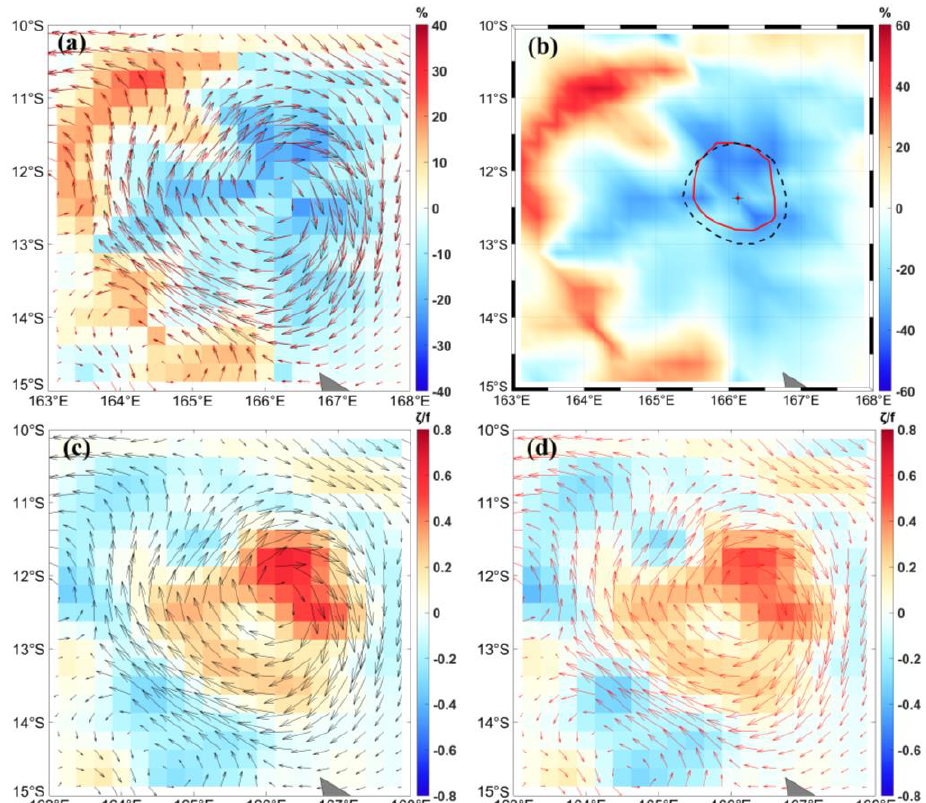
Figure 4. Cyclogeostrophic correction of an isolated cyclonic eddy in the southern hemisphere on 1 February 2003. ( a ) Spatial comparison of corrected velocity and initial geostrophic velocity. The black vectors represent the initial geostrophic current, the red vectors represent the cyclogeostrophic current, and the background color represents the relative difference of velocity. ( b ) The black dotted circle and dot represent the cyclonic eddy boundary and center derived from the altimeter, the red solid circle and plus sign represent the eddy boundary and center after the cyclogeostrophic correction, and the background color represents the relative difference of the eddy kinetic energy. ( c ) The black vector arrow represents the initial geostrophic current, and the background color represents the normalized relative vorticity ( Ro ) of the initial geostrophic current. ( d ) The red vectors represent the cyclogeostrophic current, and the background color represents the normalized relative vorticity ( Ro ) of the cyclogeostrophic current.